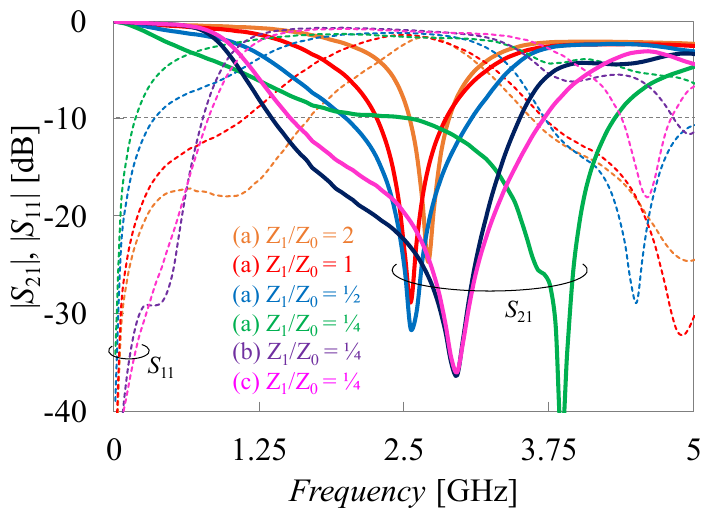
Figure 8. Measured | S 21 | and | S 11 | results of rectangular stubs, with different impedance ratios Z 1 / Z 0 as shown in Figure 5a–c. Table 1. Stop bandwidths in the case of rectangular stubs.